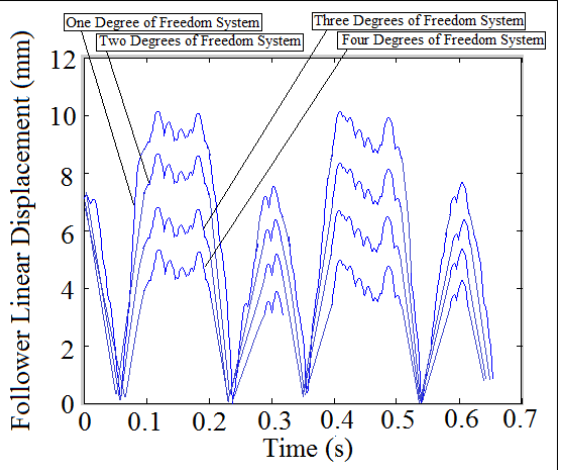
Figure 6. Follower linear displacement against time using multi-degrees of freedom systems. As stated earlier, the follower moved with three degrees of freedom because of the clearance between the follower and its guide. The variation of nonlinear response of the follower displacement was intangible in the x-direction while there was a variation in the y-direction for the follower displacement as indicated in Figure 7.